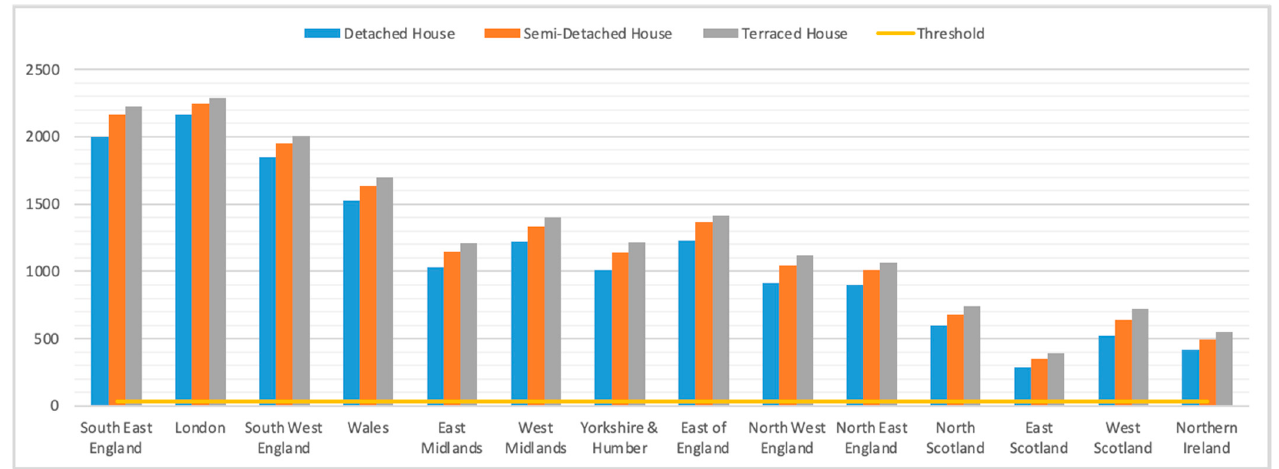
Figure 10. Base model annual bedroom overheating with PROMETHEUS 2080s, high-emissions cli- mate data; line shows 32 h overheating threshold.